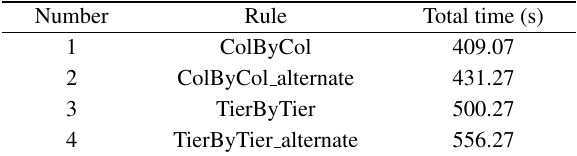
Table 2 Makespan for each empirical storage